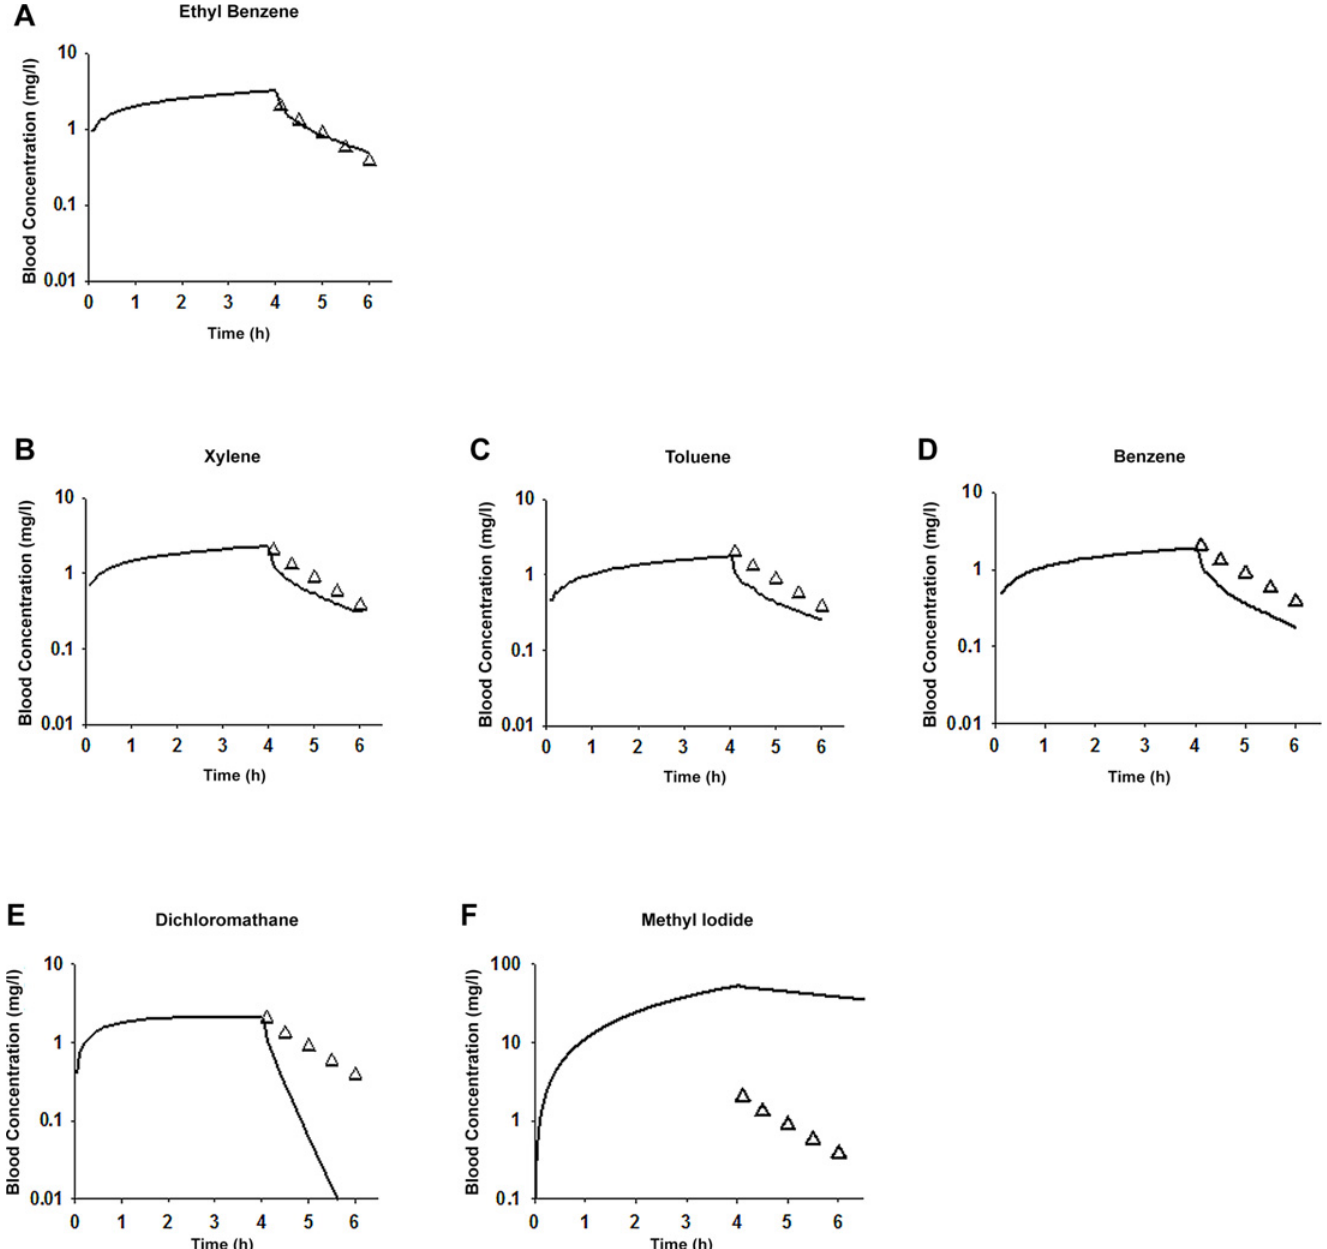
Fig 4. Case study with ethylbenzene. Comparing blood concentrations of ethylbenzene (triangle symbols) from rats exposed to 100 ppm ethylbenzene for four hours [29] and simulated blood concentrations of ethylbenzene (solid lines) based on the (A) ethylbenzene PBPK model [58]; (B) xylene PBPK